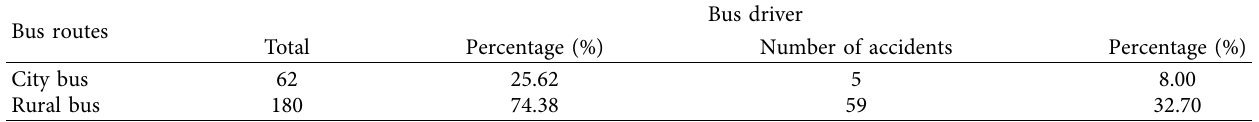
Table 10: Distribution of bus routes.